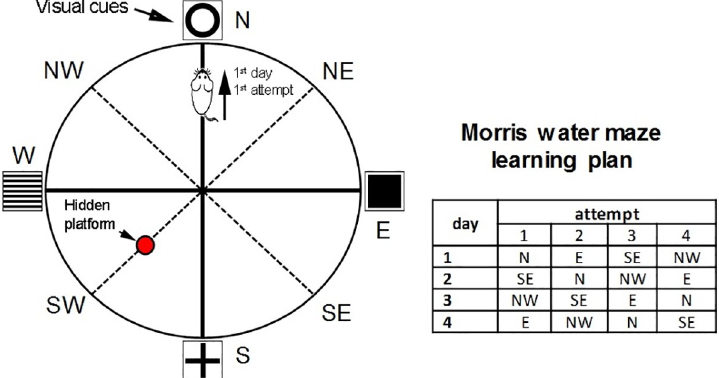
Fig 2. The schematic representation of Morris water maze apparatus and the order of animal